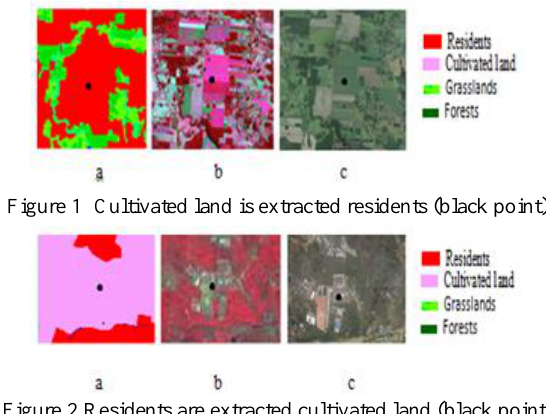
Figure 2 Residents are extracted cultivated land (black